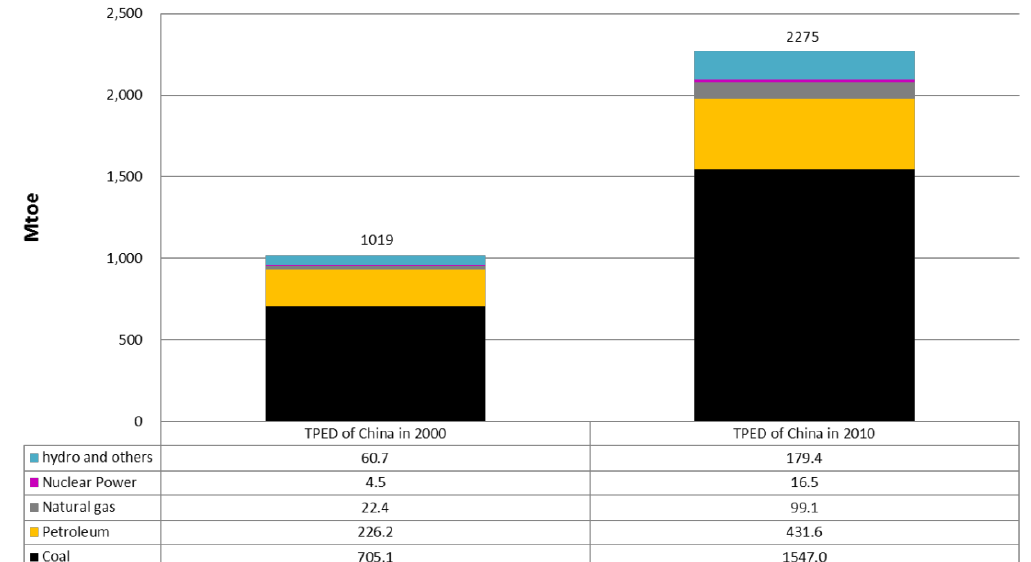
Figure 1. China’s primary energy consumption in 2000 and